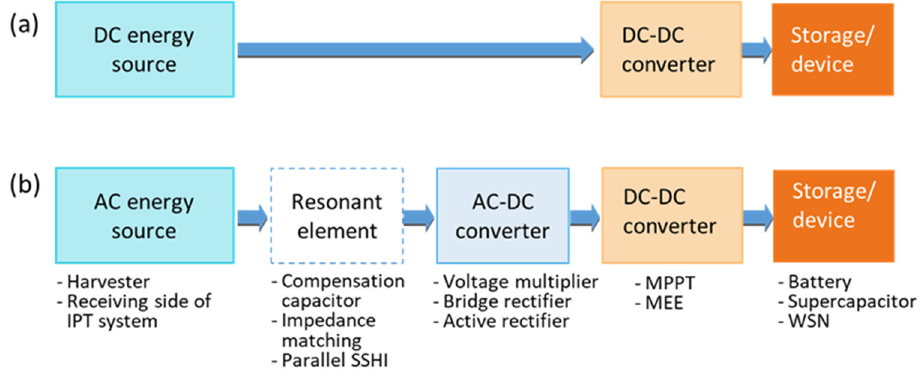
Figure 7. General structure of energy management for ( a ) DC; and ( b ) AC sources.